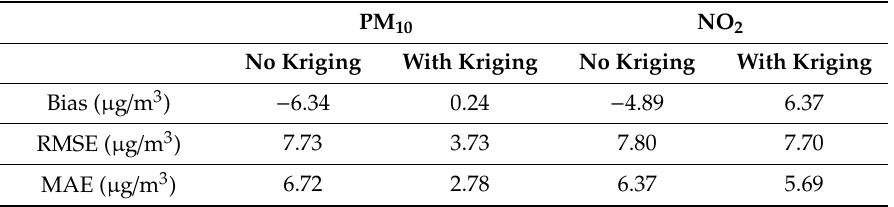
Table 3. Skill scores for PM 10 and NO 2 annual average with kriging and without kriging.